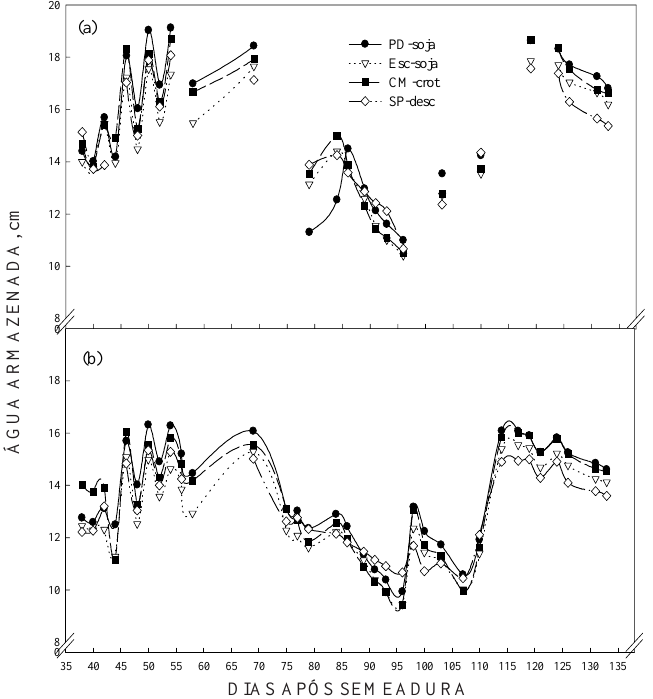
Figura 7. Lâmina média acumulada de água armazenada de 0-0,60 m (a) e de 0,10 a 0,60 m (b) em solo sob diferentes sistemas de